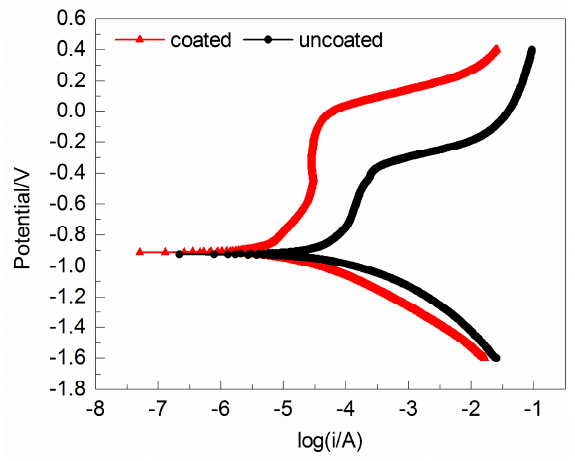
Figure 9. Polarization curves of coated and uncoated specimens in the 3.5% NaCl solution. Table 3. Potentiodynamic polarization parameters.